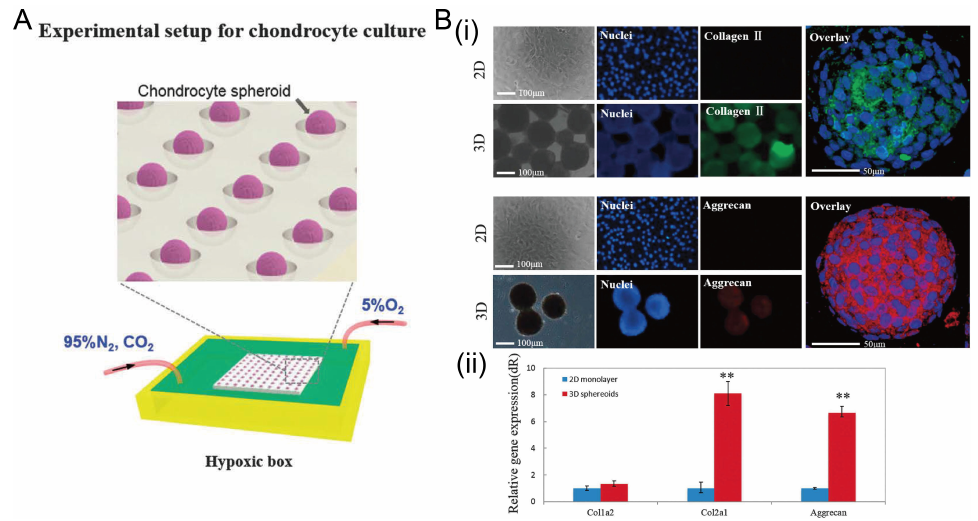
Figure 15. The formation of chondrocyte spheroids under a hypoxia environment in concave microw- ells. ( A ) Schematic view of the experimental setup for chondrocyte spheroid culture. ( B ) Fluorescent images of chondrocyte cells in 2D and 3D culture mode (i), and the comparison of gene (collagen II, collagen I, and aggrecan) expression in different culture modes (ii) [91]. ** p < 0.01. Reprinted (adapted) from [91]. Copyright (2015) with permission from Oxford University Press.